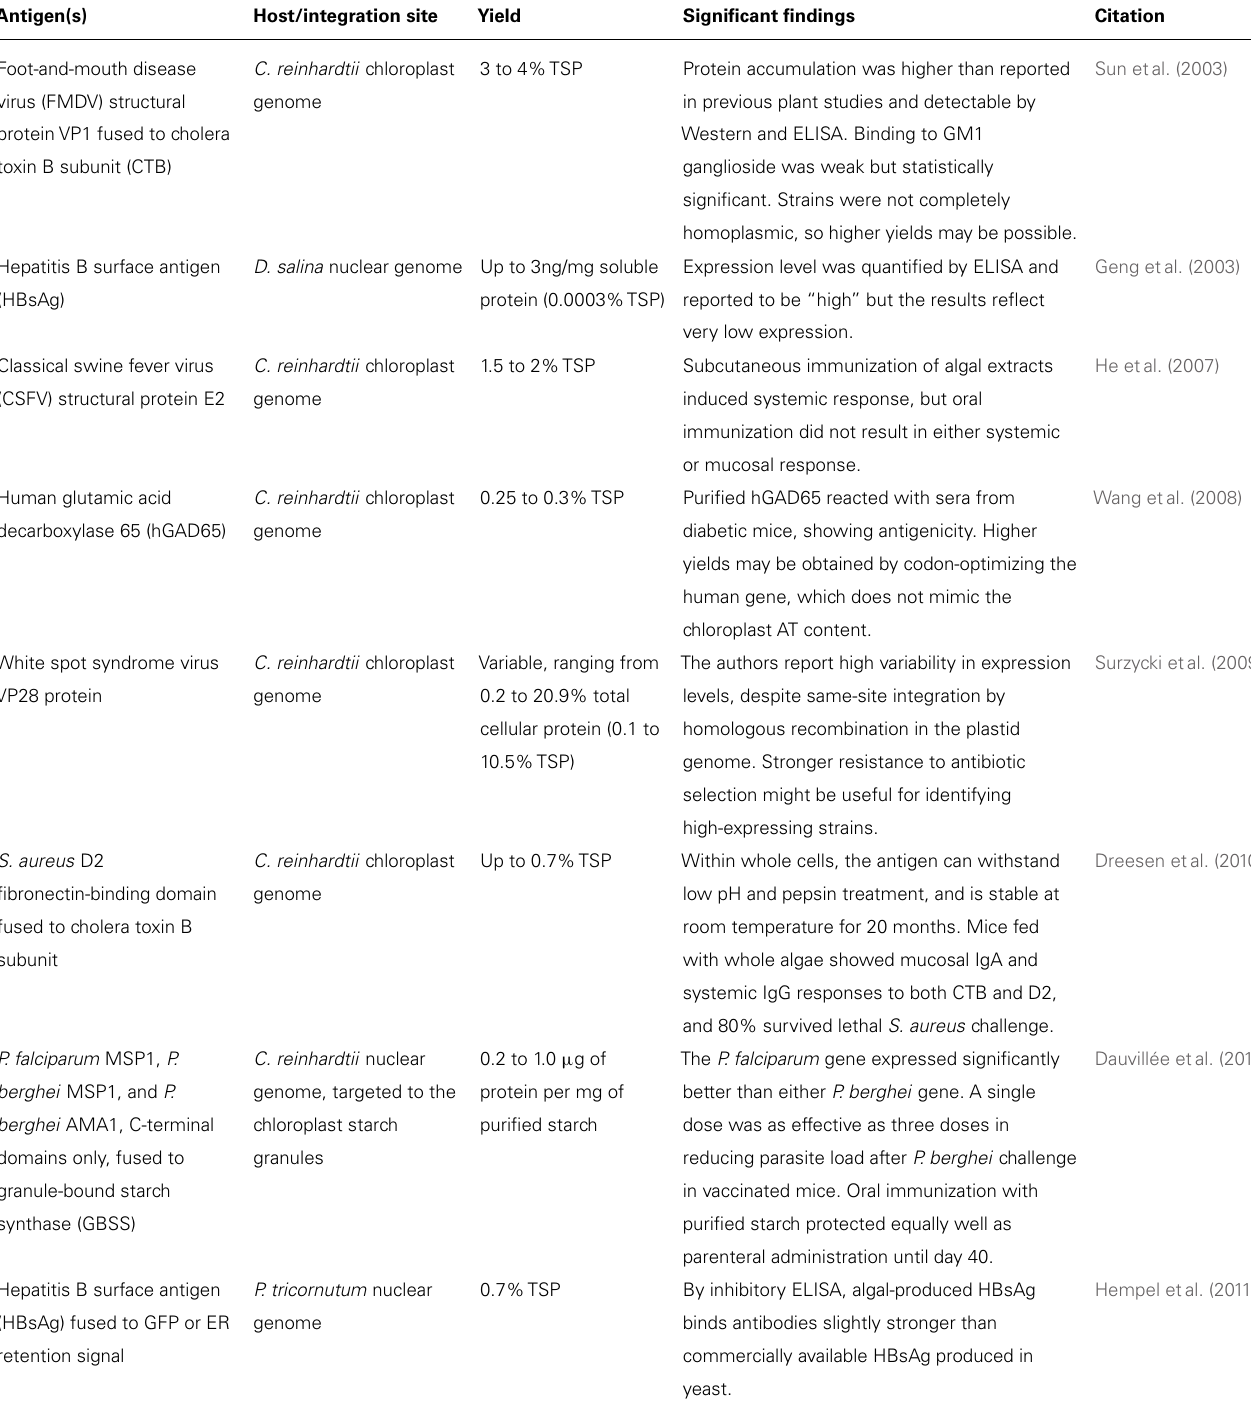
Table 1 | Summary of algal-produced vaccines and significant